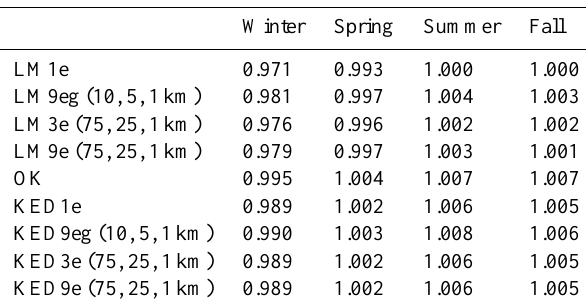
Table 4. Relative bias B calculated over all stations for different seasons using different interpolation models (see Table 1 for model acronyms).